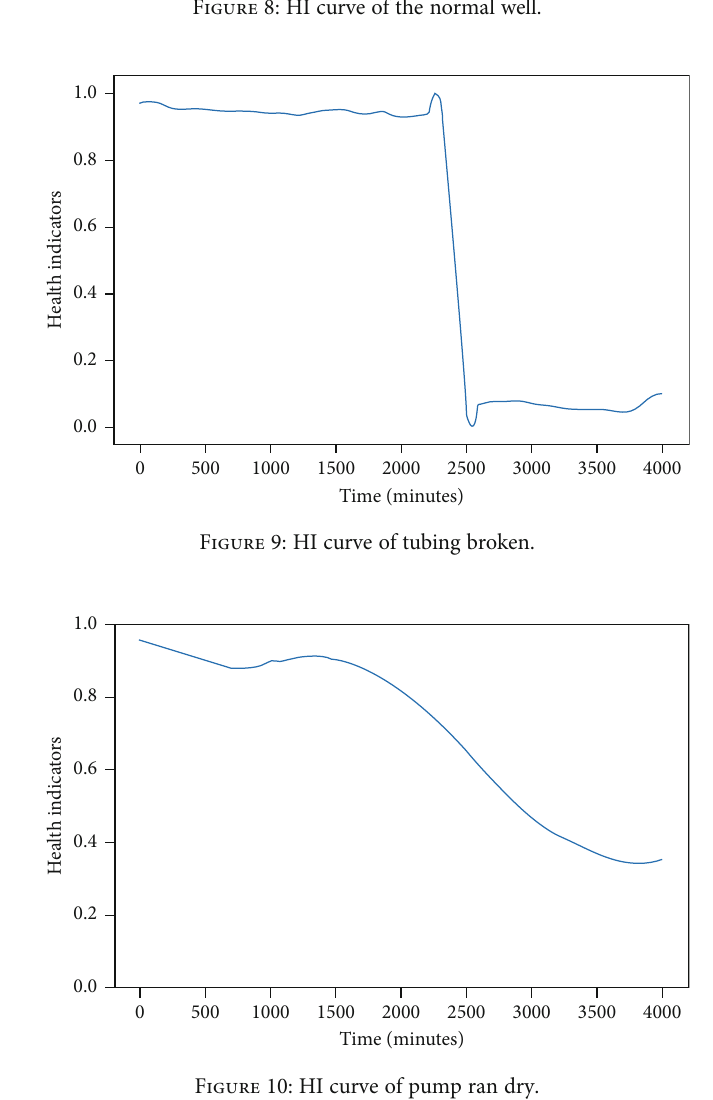
Figure 8: HI curve of the normal well.